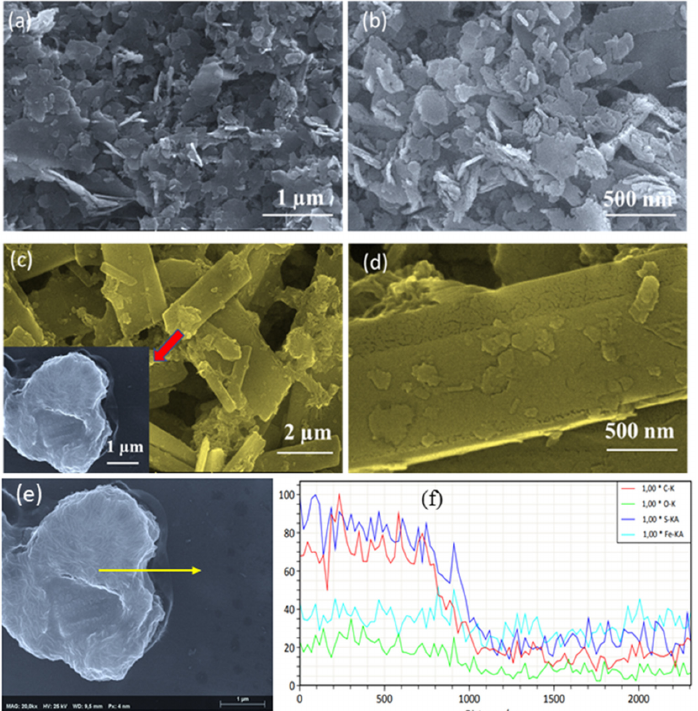
Figure 1. SEM images of ( a , b ) δ -FeOOH, ( c , d ) ABT/ δ -FeOOH; ( e ) SEM image with a yellow arrow indicating the EDX line scan position; ( f ) the relative intensities of the different elements (i.e., C, O, S, and Fe) obtained by EDX line scan on the surface of ABT/ δ -FeOOH material. Additionally, to analyze how the elements S and Fe are distributed in the functionalized material, EDX mapping was accomplished, as seen in Figure 2.